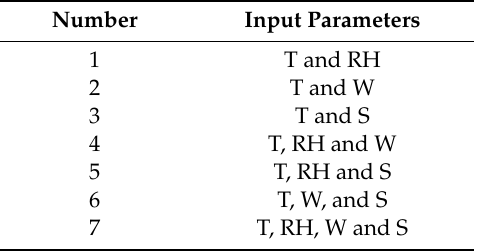
Table 4. Statistical results of the computations for the defined scenarios for GPR, IBK, RF, SVR models.